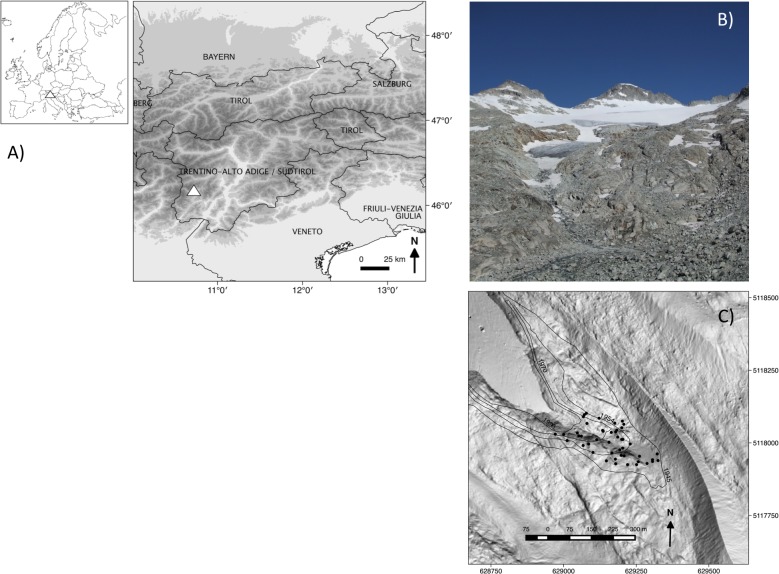
(A) Location of the study area (triangles), (B) image of the glacier foreland in 2011, and (C) a map of how the glacier has retreated from 1945 (external isochrones) to 2006 (date of the digital terrain model used as a base map), with the positions of the 46 1 m × 1 m-plots (black dots).Coordinates are reported according to the geographic coordinate reference systems: (A) WGS84 (EPSG: 4326) and (C) ETRS 89/UTM zone 32N (EPSG: 25832).